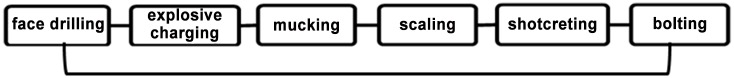
Operations of mobile mining equipment in mine excavation.